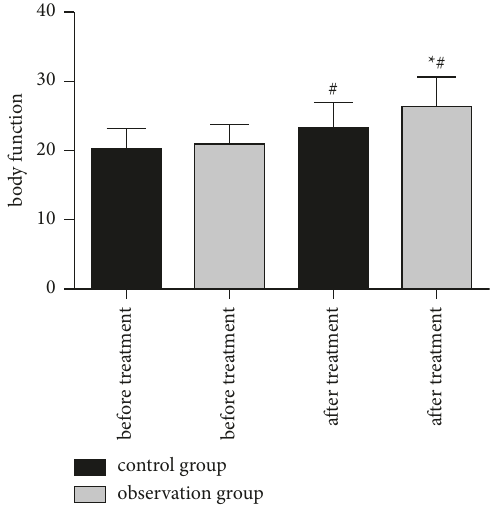
Figure 11: The mental and psychological scores of the two groups of patients at different times.Note: Compared with the same group before treatment, # ∗ P < 0 . 05; compared with the control group, ∗ P < 0 . 05.